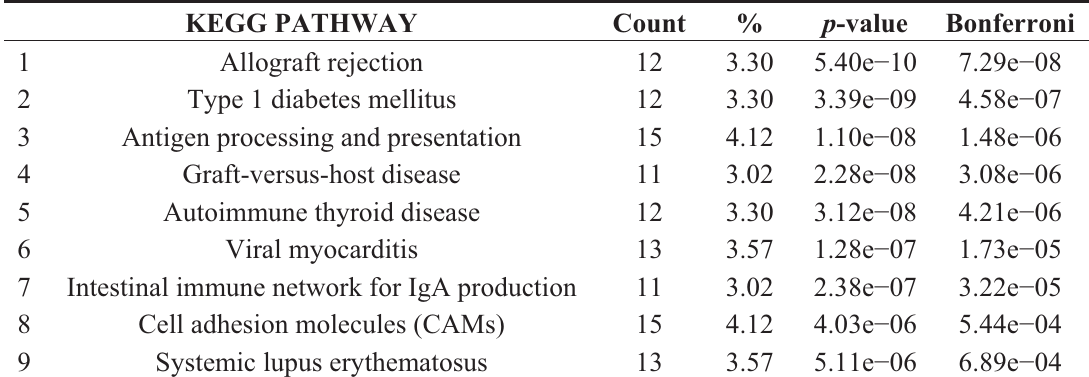
Table 6. KEGG pathway-based annotation of T1D genes harboring Alu elements. The enriched pathway names are followed by the number of genes within the enriched pathway (count), the percentage of genes with the enriched pathway (%), p -values based on EASE scores, and Bonferroni